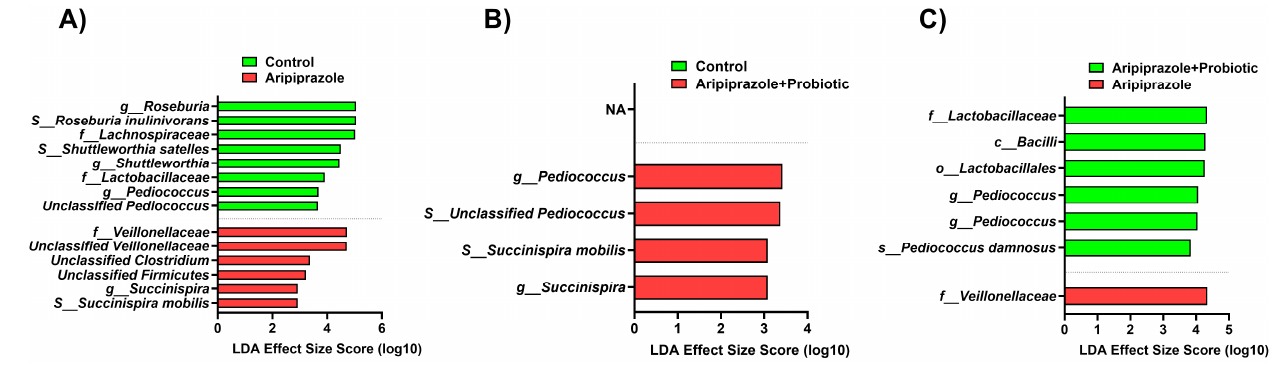
Figure 4. Histograms of the linear discriminant analysis (LDA) scores showing microbial taxa that vary significantly in abundance between: ( A ) no-treatment control and aripiprazole treatment, ( B ) no-treatment control and aripiprazole + probiotic treatment, and ( C ) aripiprazole and aripiprazole + probiotic